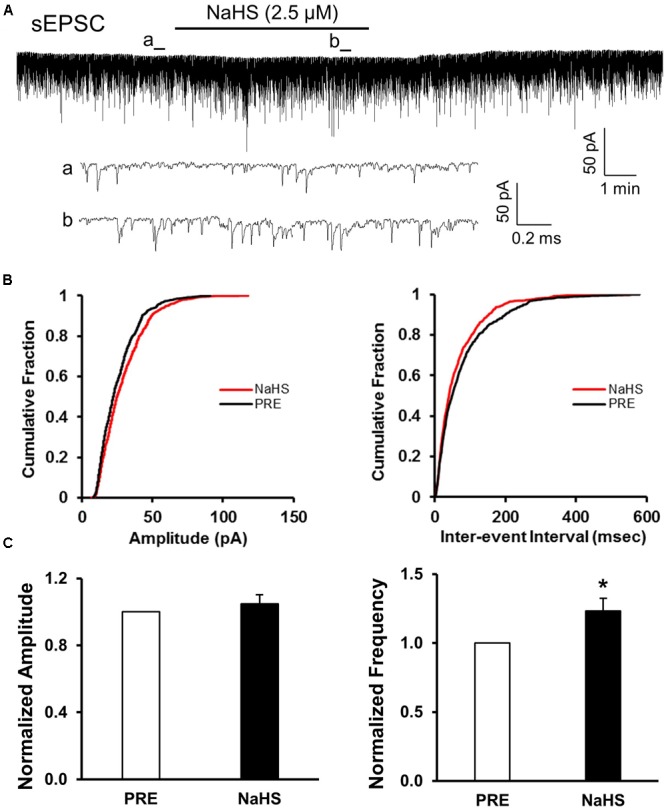
NaHS enhanced the frequency of sEPSCs in control group. (A) Representative current traces of sEPSCs recorded in the presence and absence of NaHS (2.5 μM). a: An expanded trace for sEPSC recorded in the absence of NaHS; b: a expanded trace for sEPSC recorded in the presence of NaHS. (B) Cumulative distribution analysis of amplitude and inter-event intervals from one representative SG neuron. NaHS had no discernible effect on the amplitude, but NaHS caused a notably shift toward shorter inter-event intervals (n = 10, P < 0.05, Kolmogorov–Smirnov test). (C) Bar plot showing NaHS significantly increased mean frequency of sEPSC without change in peak amplitude. n = 9, ∗P < 0.05.